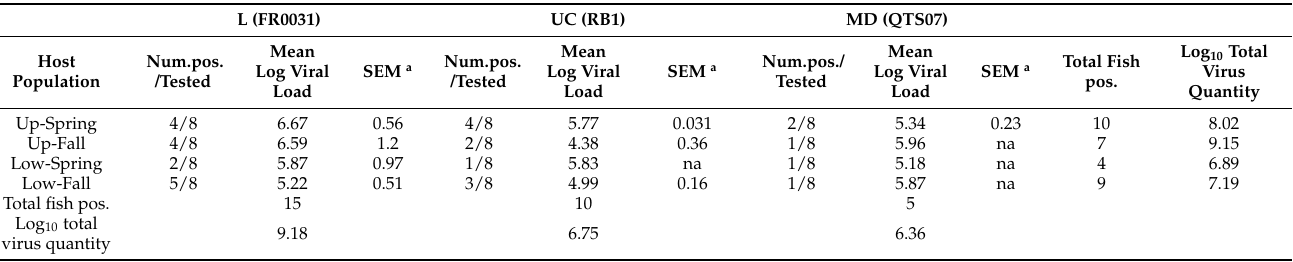
relative to the MD viral strain. Table 6. Persistence of IHNV infection in juvenile CRB Chinook salmon at 30 days post exposure to L, UC, and MD strains of IHNV at a single high dose of 2 × 10 5 plaque-forming units mL − 1